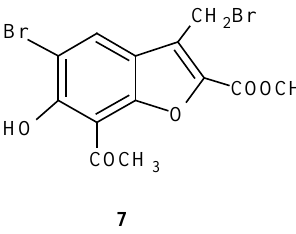
Figure 5. The structure of methyl 7-acetyl-5-bromo-3-(bromomethyl)-6-hydroxy-1- benzofuran-2-carboxylate ( 7